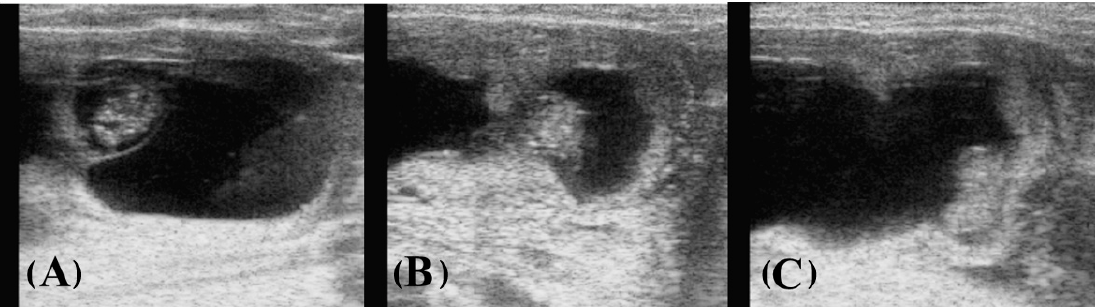
Figure 1. Sequence of gray-scale sonograms showing the twin reduction procedure on a day 29 twin embryo. Scale marks on the left are in cm. ( A ) The amniotic vesicle of the embryo is transrectally held with the thumb and half. ( B ) Pressure and rupture of the amniotic vesicle. ( C ) Disappearance of amnion and cessation of the embryonic heartbeat. Cows did not show any sign of discomfort.